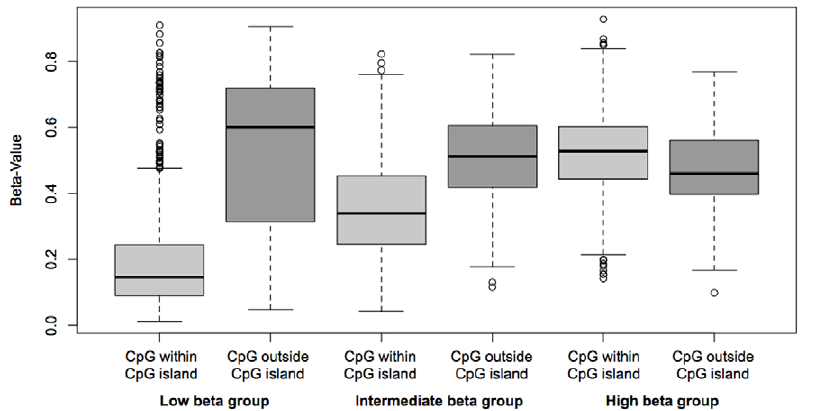
Figure 2. Box plots of methylation values ( b ) in the low, intermediate and high b groups according to the location of a CpG locus within a CpG island (light grey) or outside a CpG island (dark grey). Within the low and intermediate b groups, mean b -values for CpG loci outside a CpG island were significantly higher than mean b -values for CpG loci within a CpG island. Within the high b group, mean b -values for CpG loci outside a CpG island were significantly decreased.